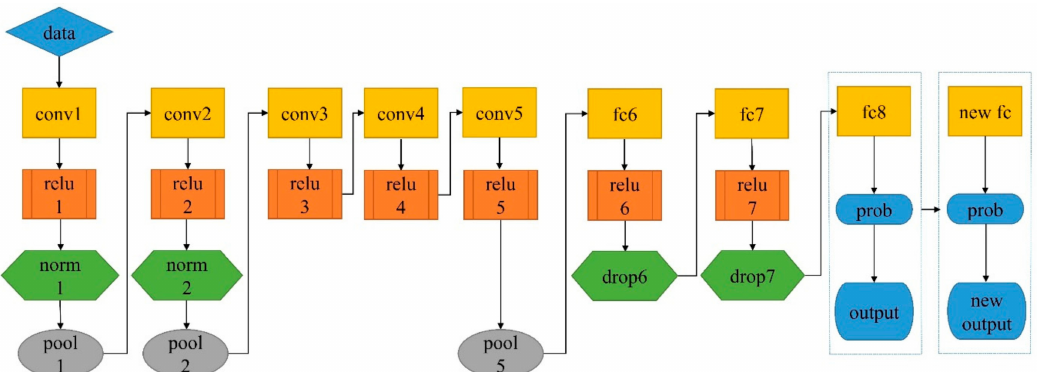
Figure 7. The architecture of AlexNet: conv, relu, norm, pool, fc, drop, and prob are the abbreviations of convolution layer, relu layer, cross channel normalization layer, maxpooling layer, fully connected layer, dropout layer, and softmax layer, respectively.